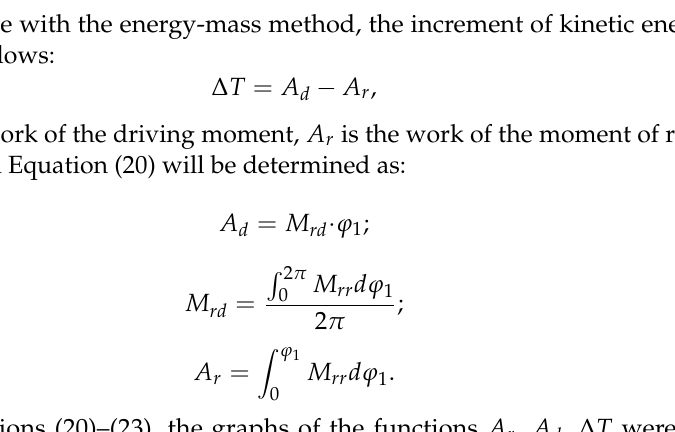
(cid:3031)(cid:3010) (cid:3293) (𝜑 ) . (cid:2869) (cid:3031)(cid:3101) (cid:3117)